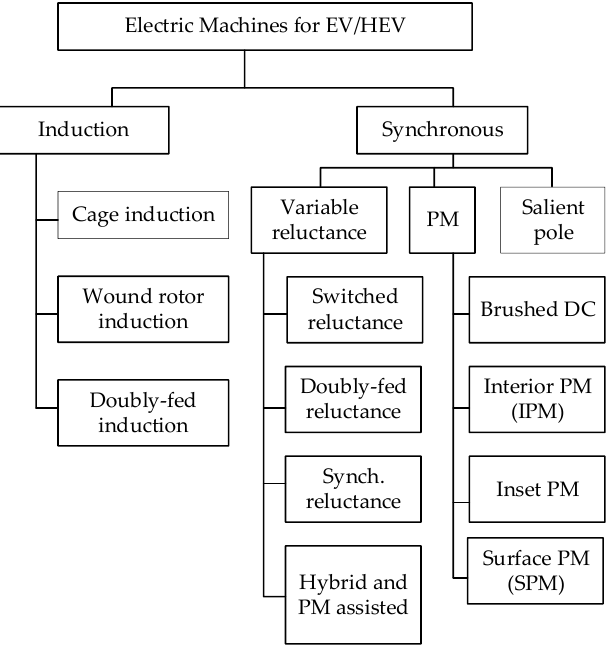
Figure 1. Motor types available for electric vehicles/hybrid electric vehicles (EV/HEVs) ( adapted from [20] ) .